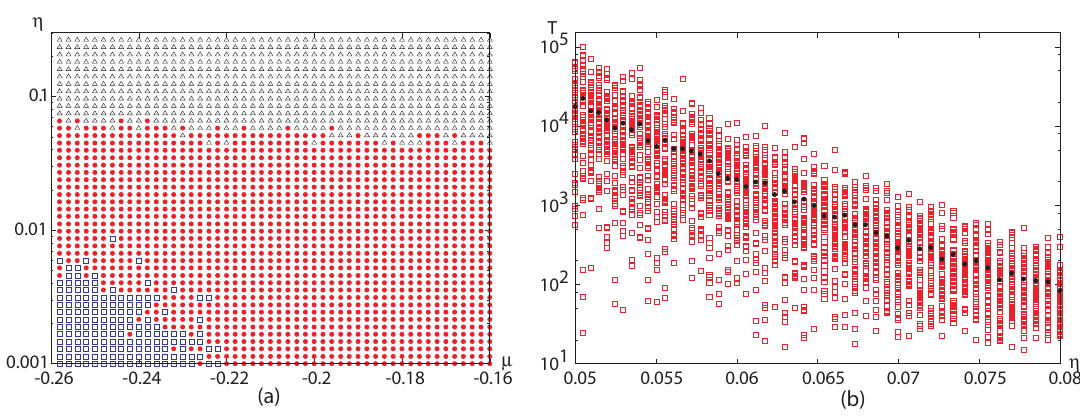
Figure 1. Phase diagram: Effect of additive noise on exploding solitons for a fixed time scale T = 10 4 . ( a ) Black triangles ( (cid:52) ) denote filling-in to the spatially homogeneous finite amplitude solution under the influence of additive noise. Red solid circles ( • ) stand for exploding dissipative solutions and blue squares ( (cid:3) ) for noisy non-explosive localized solutions; ( b ) Filling-in time for the transition from an exploding dissipative soliton to filling-in under the influence of additive noise for µ = − 0.25. The average time scale T for filling-in is shown as a function of the noise strength η . Black solid circles ( • ) represent an average of over 50 realizations shown as open squares ( (cid:3) ).